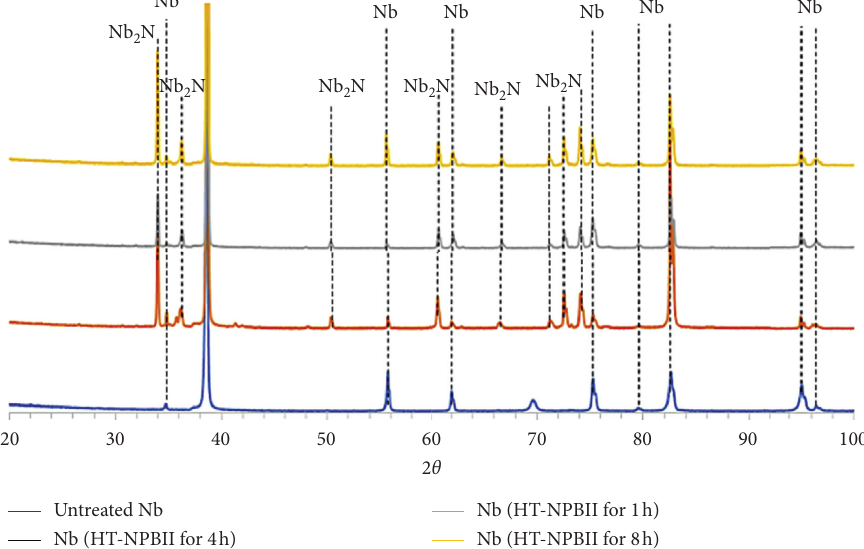
Figure 3: XRD for Nb samples treated by HT-NPBII at different experimental conditions in comparison with untreated